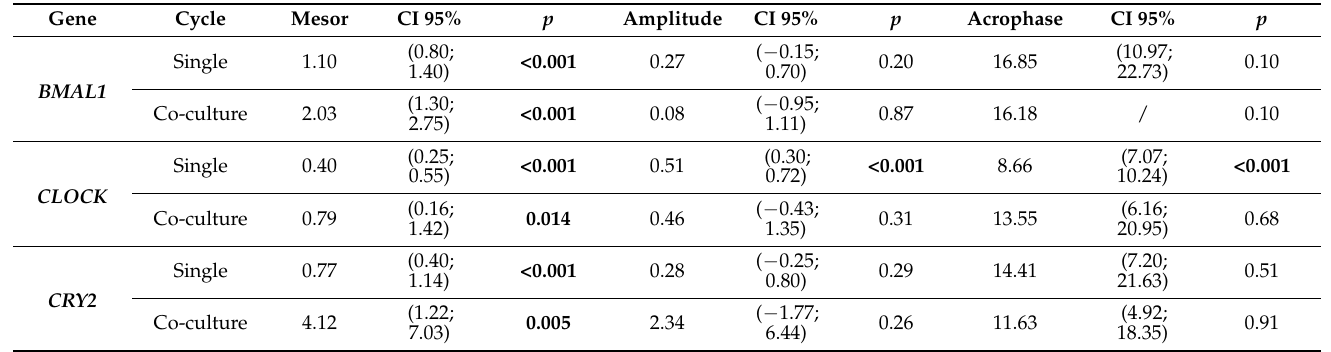
Figure 3. Preeclamptic placental macrophages and circadian clock gene expression. Placental macrophages were isolated from nine women who developed preeclampsia and ( A ) single culture ( n = 9) or ( B ) co-culture with trophoblasts ( n = 3, heterologous) were performed. The expression of the clock genes (BMAL1, CLOCK, PER2, CRY2, and NR1D1) was evaluated by qRT-PCR every 4 h for 24 h and expressed in fold change from the maximum value. Each sinusoid (in gray) represents the expression of the clock genes over time for each donor after adjustment of the values by the cosinor model (mean of 3 technical replicates for each donor). The mean of the fold change of biological replicates is represented in blue. The statistical analysis was performed using the cosinor function using R studio (v3.4.0, Boston, MA, USA). Table 2. Rhythmic parameters (mesor, amplitude, and acrophase) for preeclamptic macrophages. A p value < 0.05 for mesor, amplitude, and acrophase implies a rhythmicity of the investigated gene.